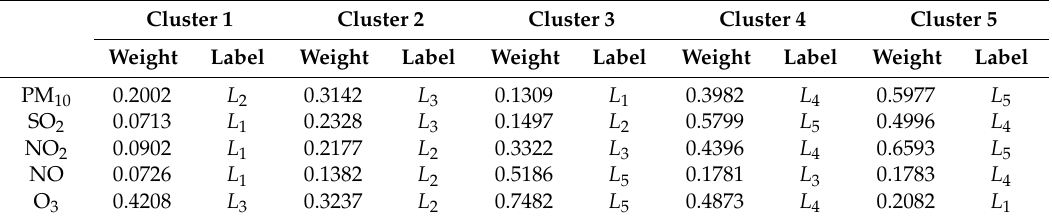
Table 8. The mean weight values of each cluster group and their intra-cluster labels obtained by KM ++ . Cluster 1 Cluster 2 Label Weight Label Label